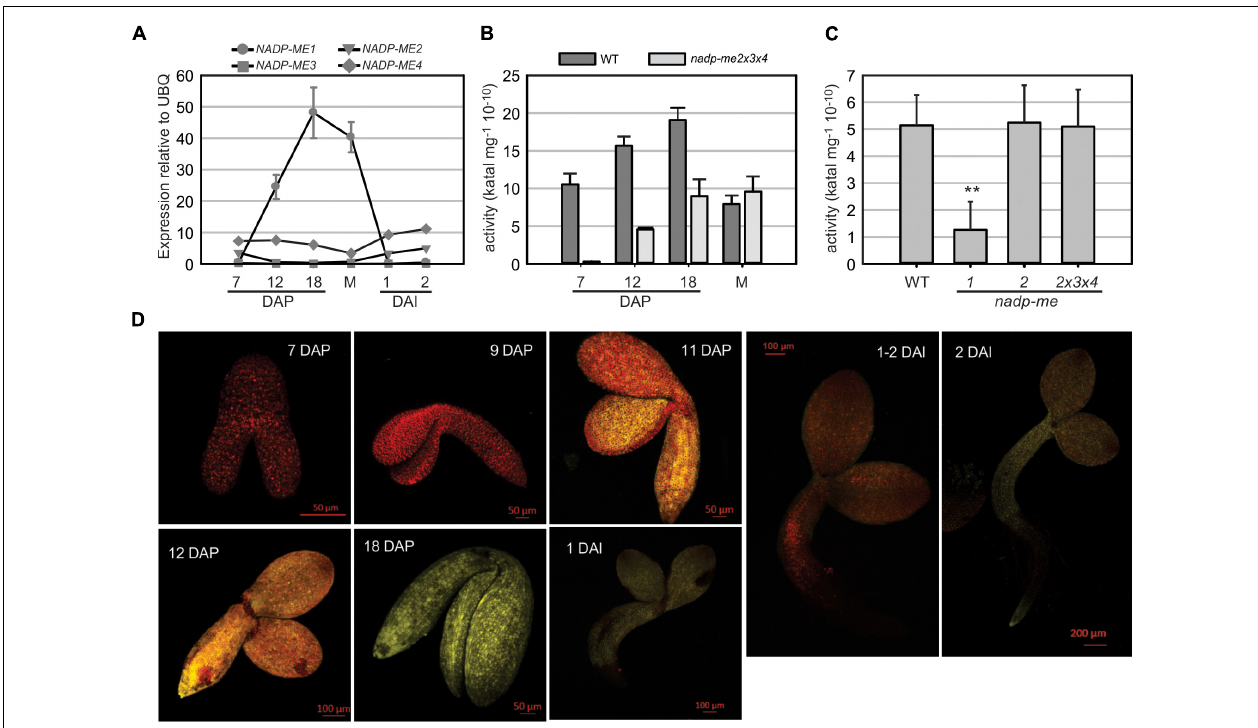
FIGURE 1 | NADP-ME1 expression in Arabidopsis seeds. (A) Relative level of the transcripts of NADP-ME genes in seeds collected at 7, 12, and 18 days after pollination (DAP), mature stage (M), and at 1 and 2 days after imbibition (DAI). The polyubiquitin 10 (UBQ) gene was used as reference. NADP-ME activity was assayed in siliques throughout maturation (B) and in mature seeds (C) for WT and simple or triple mutant lines. The values are the average of three independent experiments ± SD. In figure (C) the two asterisks ( ∗∗ ) indicates that there is a significant difference between nadp-me1 and the rest of the lines ( p < 0.001) according to the ANOVA test followed by a Bonferroni t -test of multiple comparisons versus control group (WT). (D) Expression of the fusion protein NADP-ME1::YFP during seed development and germination. The reporter contains the complete coding sequence of NADP-ME1 fused to YFP gene, under the control of the NADP-ME1 promoter. YFP fluorescence in representative embryos at 7; 9; 11; 12; and 18 DAP and at 1, 1–2, and 2 DAI are shown. Scale bars are indicated in each panel. These results were confirmed in two independent